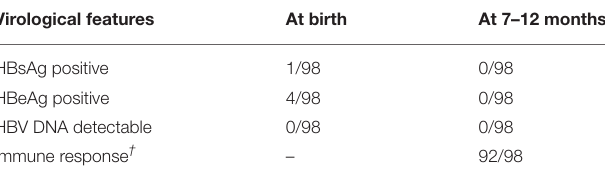
TABLE 6 | Virological features of infants from mothers with active